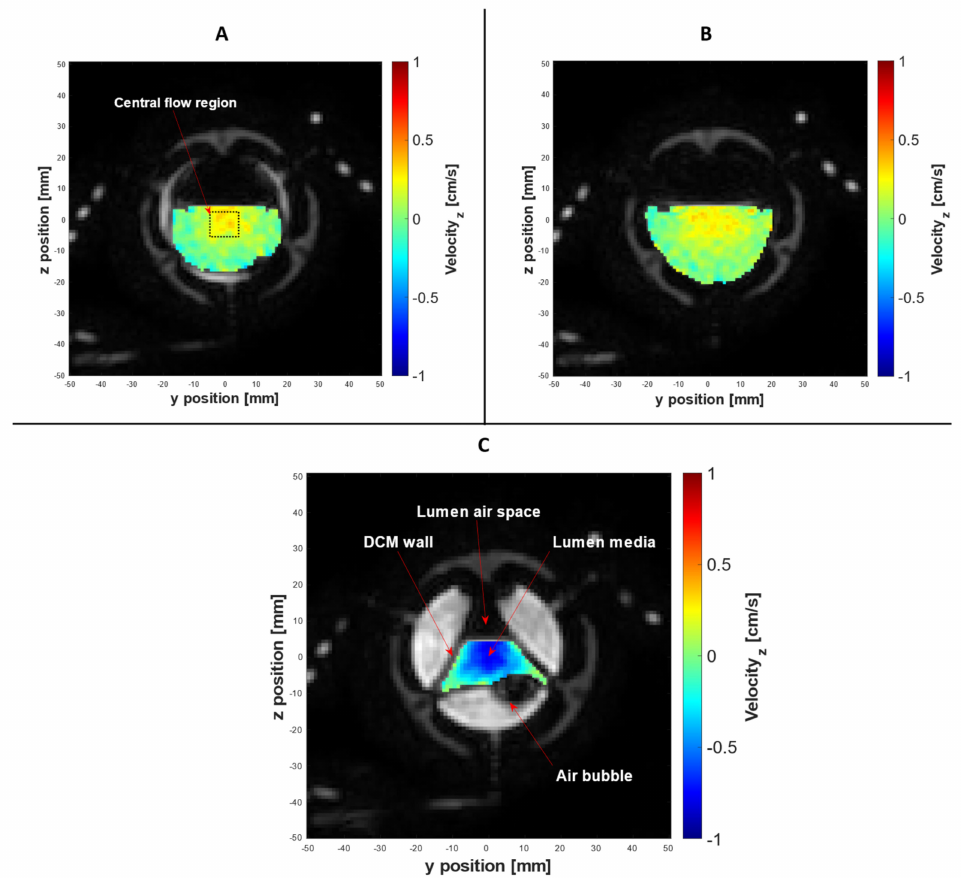
Figure 7. PC cine-MRI of the DCM, with velocity encoded in the x -axis. Simultaneous acquisition of morphological data and spatially registered flow at the cross section of tag 11, placed at the midpoint of segment 6. Parts A – C were produced by superimposing the two data sets at different stages of motility: neutral, during upstream motility (7 A ), relaxation (7 B ) and contraction (7 C